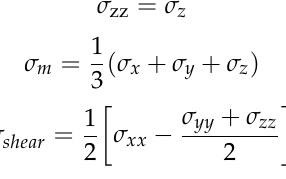
Table 2. Diffusion coefficients of the voids-free system for different shock wave velocities. Shock